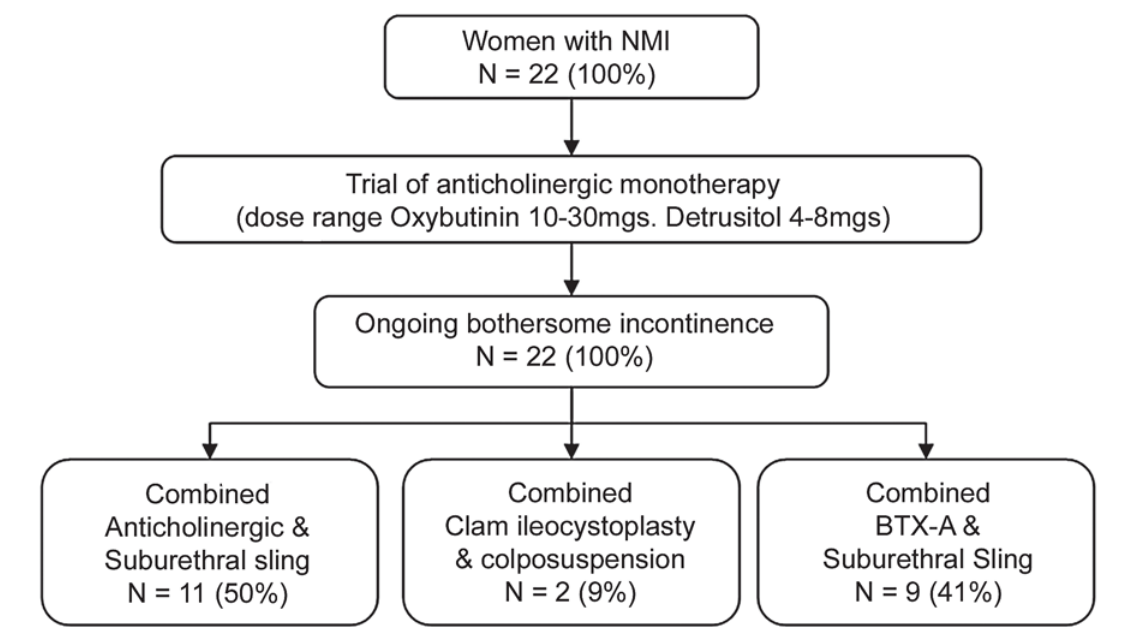
Figure 1 – Treatment algorithm for female neurogenic mixed